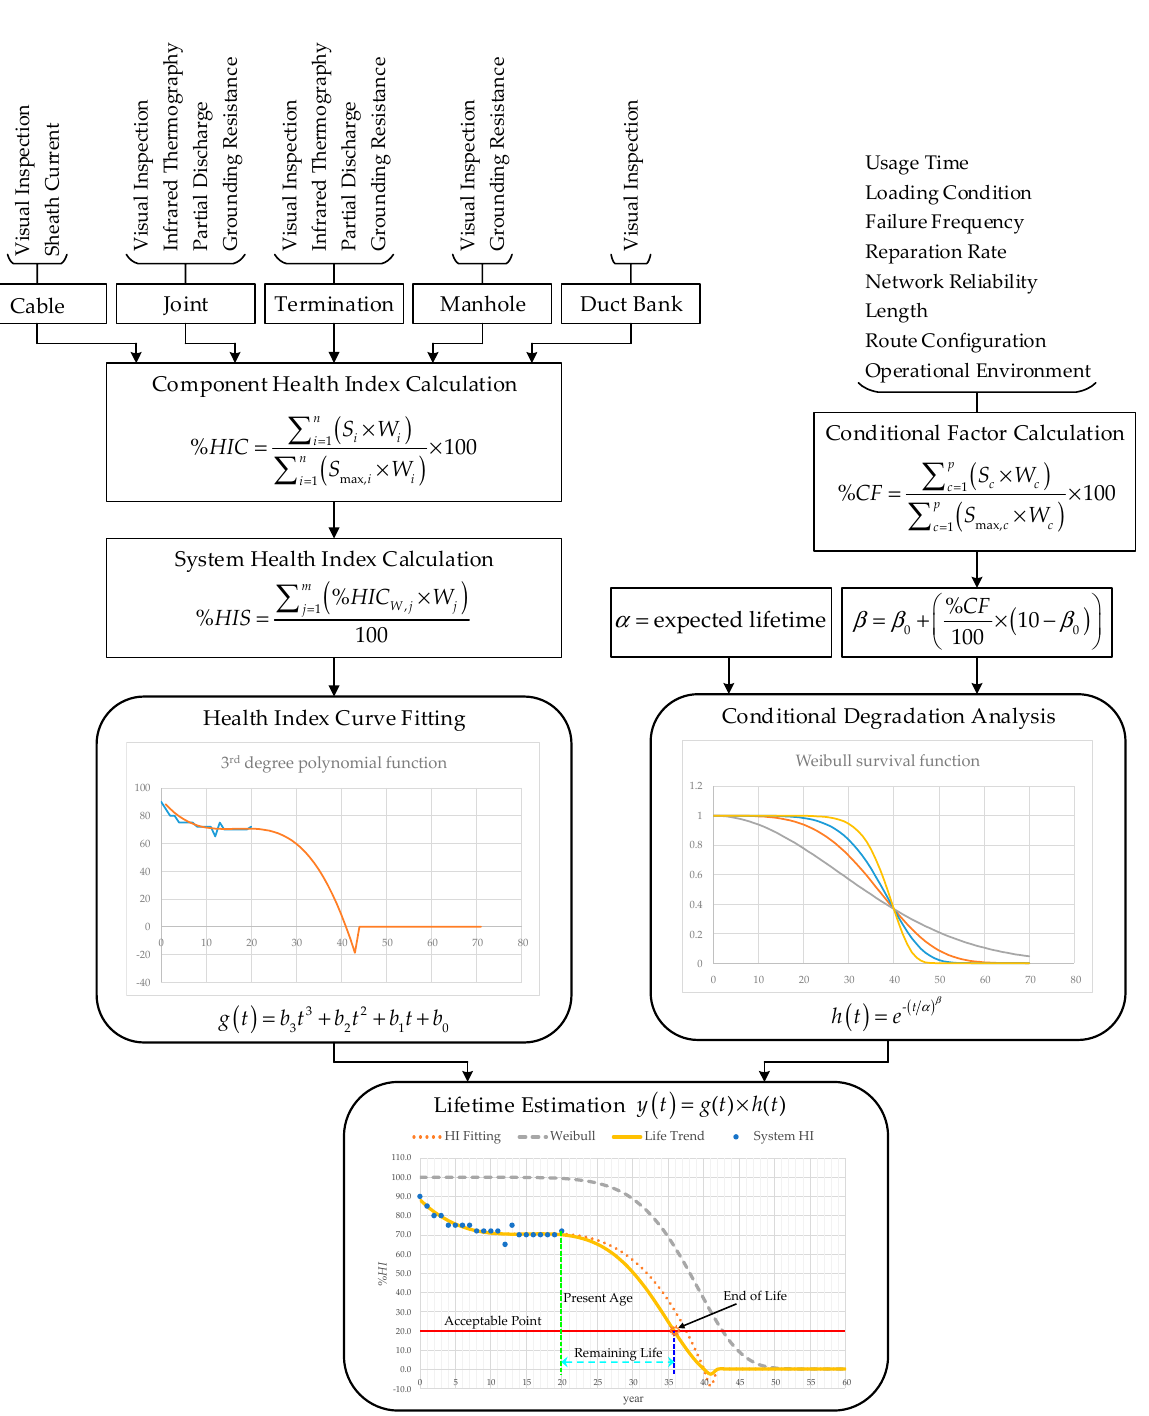
Figure 1. Lifetime estimation diagram of underground cable system.